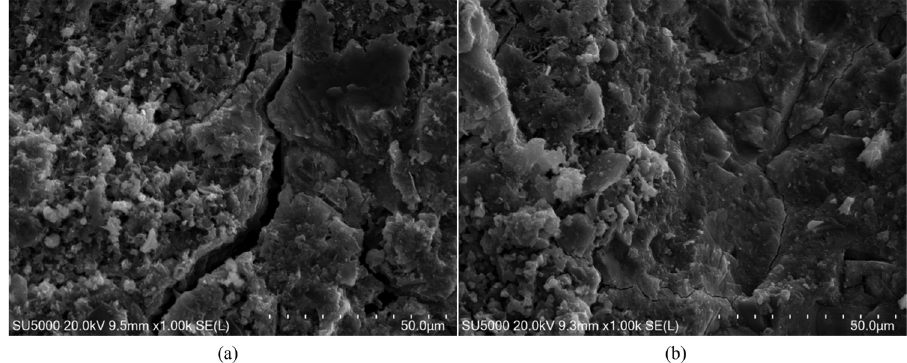
Figure 23: Micro - morphology of the cement mortar of RAC before and after NS modi fi cation. ( a ) NS - 0. ( b ) NS -